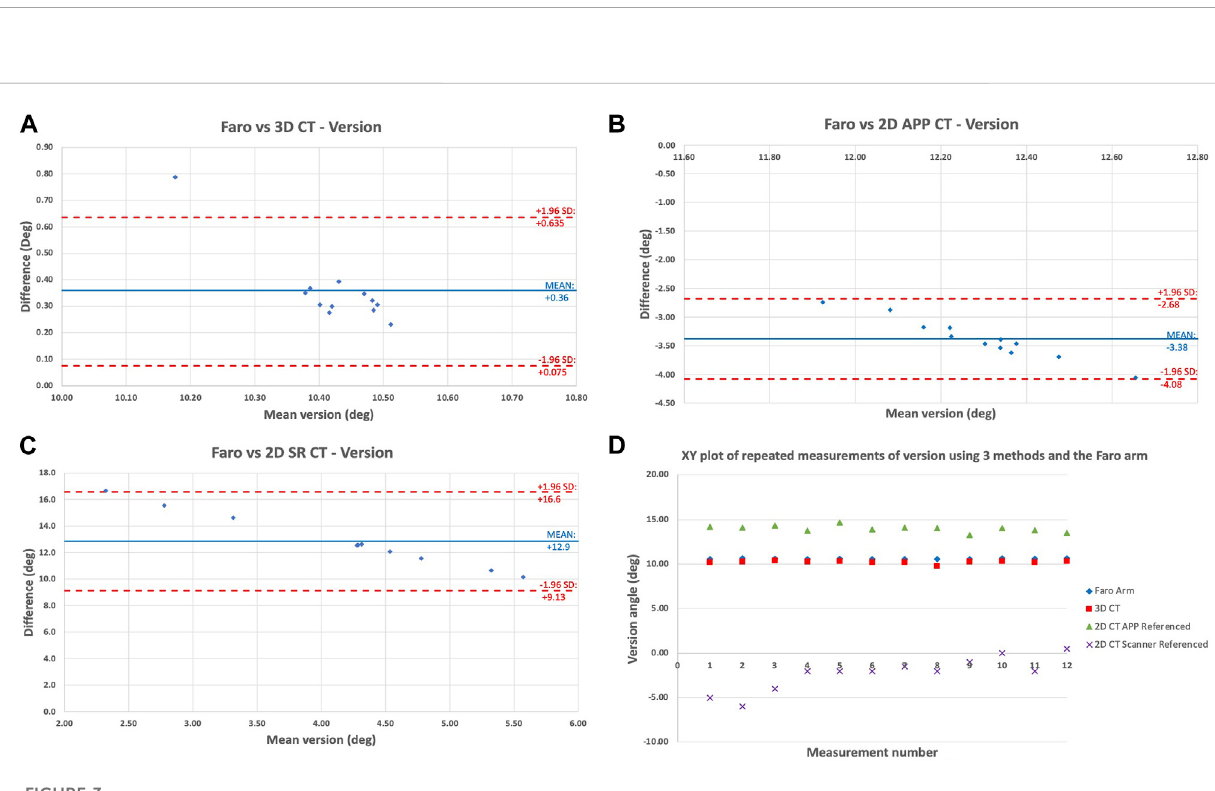
FIGURE 3 Bland-Altman plot showing the level of agreement/disagreement between the digitising arm version measurements and (A) 3D APP CT; (B) 2D APP CT; (C) 2D SR CT; (D) XY scatter plot of the 12 repeated measurements of version angles according to each of the 3 imaging methods and the Faro digitising arm for pelvis 1A by observer